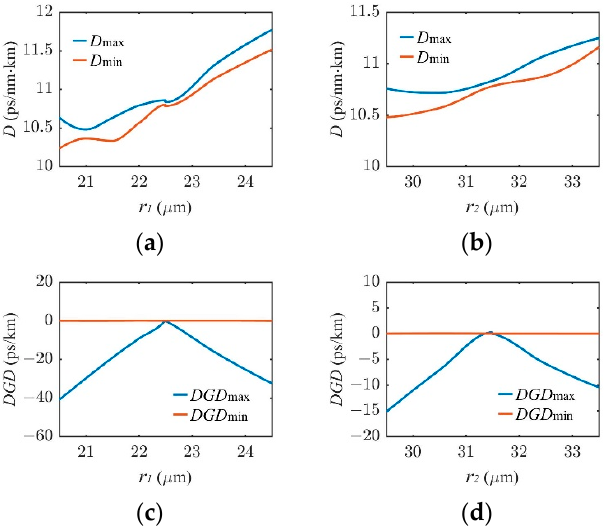
Figure 8. ( a ) Change in D with r 1 ; ( b ) Change in D with r 2 ; ( c ) Change in DGD with r 1 ; ( d ) Change in DGD with r 2